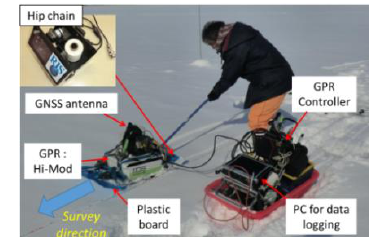
Figure 4. The GPR system used in the